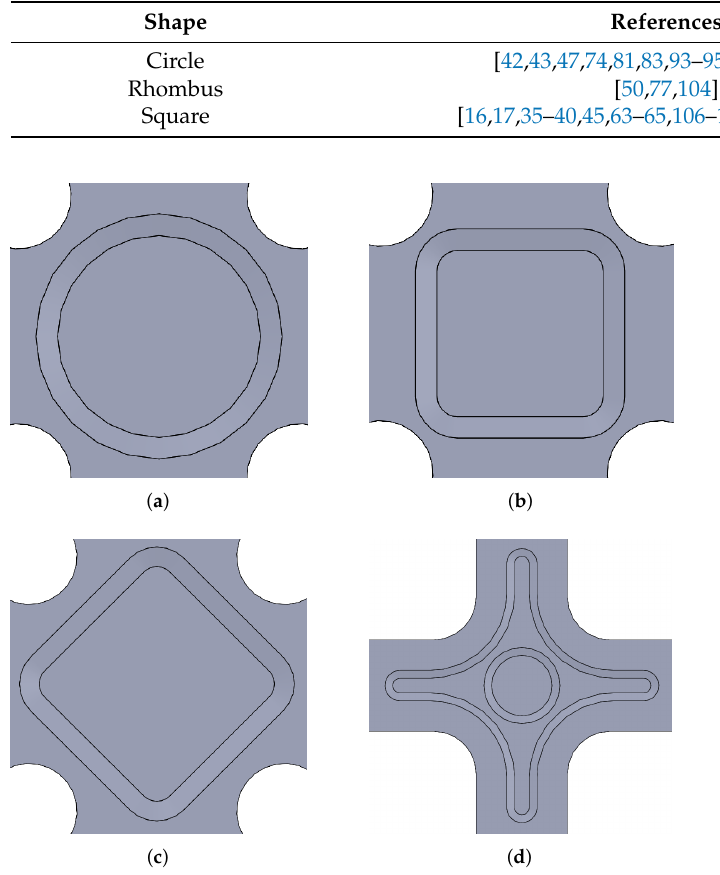
Figure 3. Gauge zone designs frequently found in literature: ( a ) Squared central zone. ( b ) Circular central zone. ( c ) Rhomboidal central zone. ( d ) Double